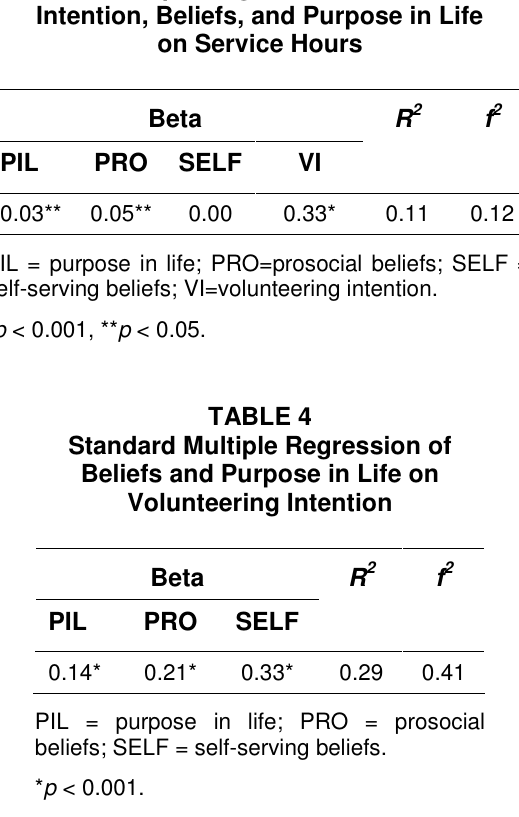
Standard Multiple Regression of Volunteering Intention, Beliefs, and Purpose in Life